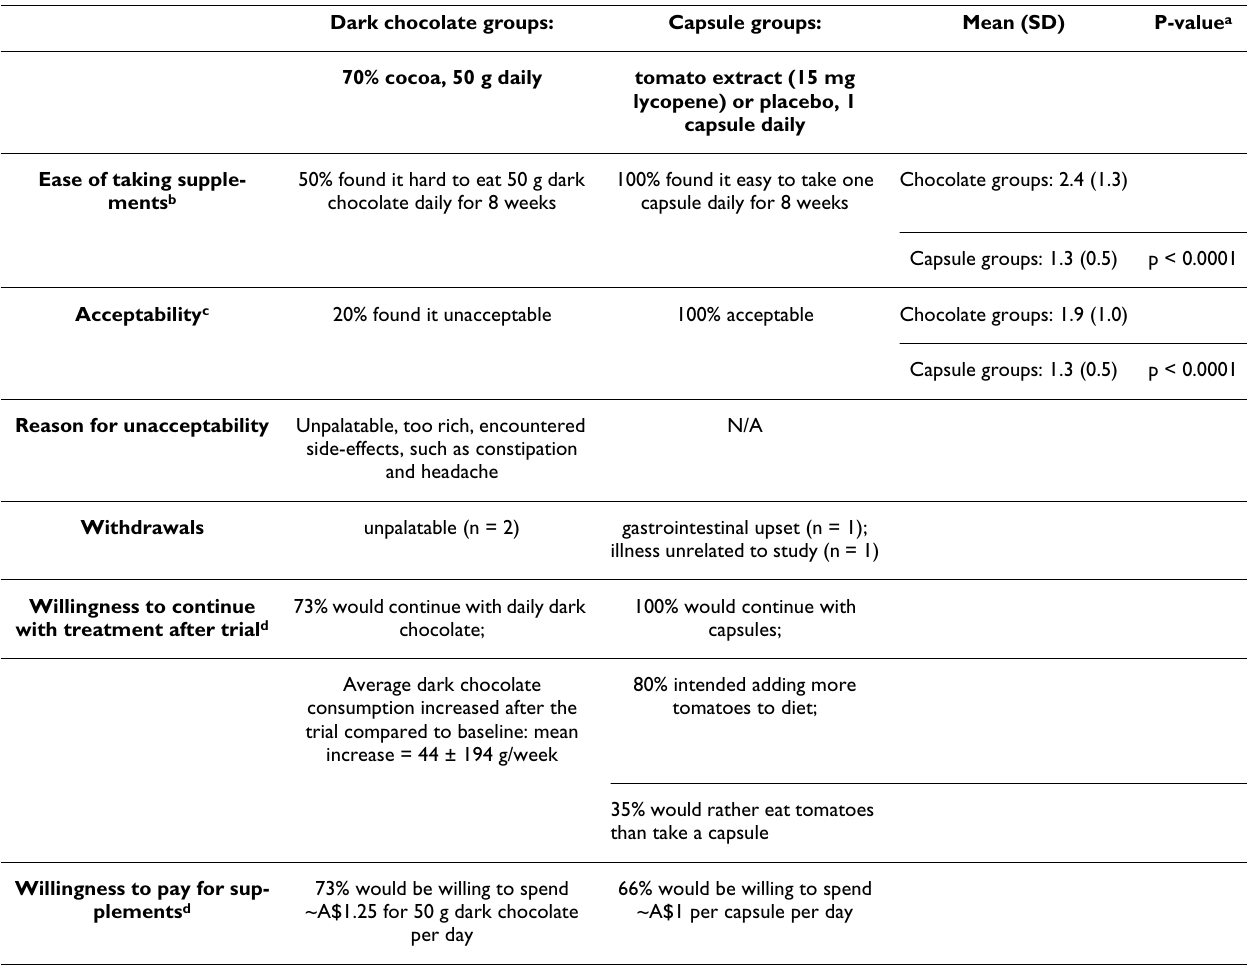
Table 4: Acceptability of treatment (chocolate or capsules) Dark chocolate groups: Capsule groups: Mean (SD) P-value a